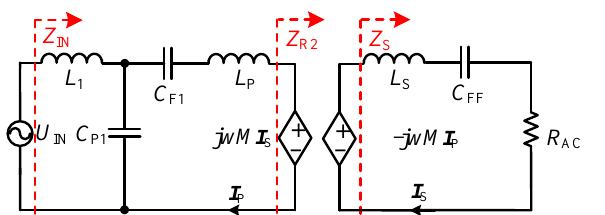
Figure 6. LCC-S compensated WPT charging systems.